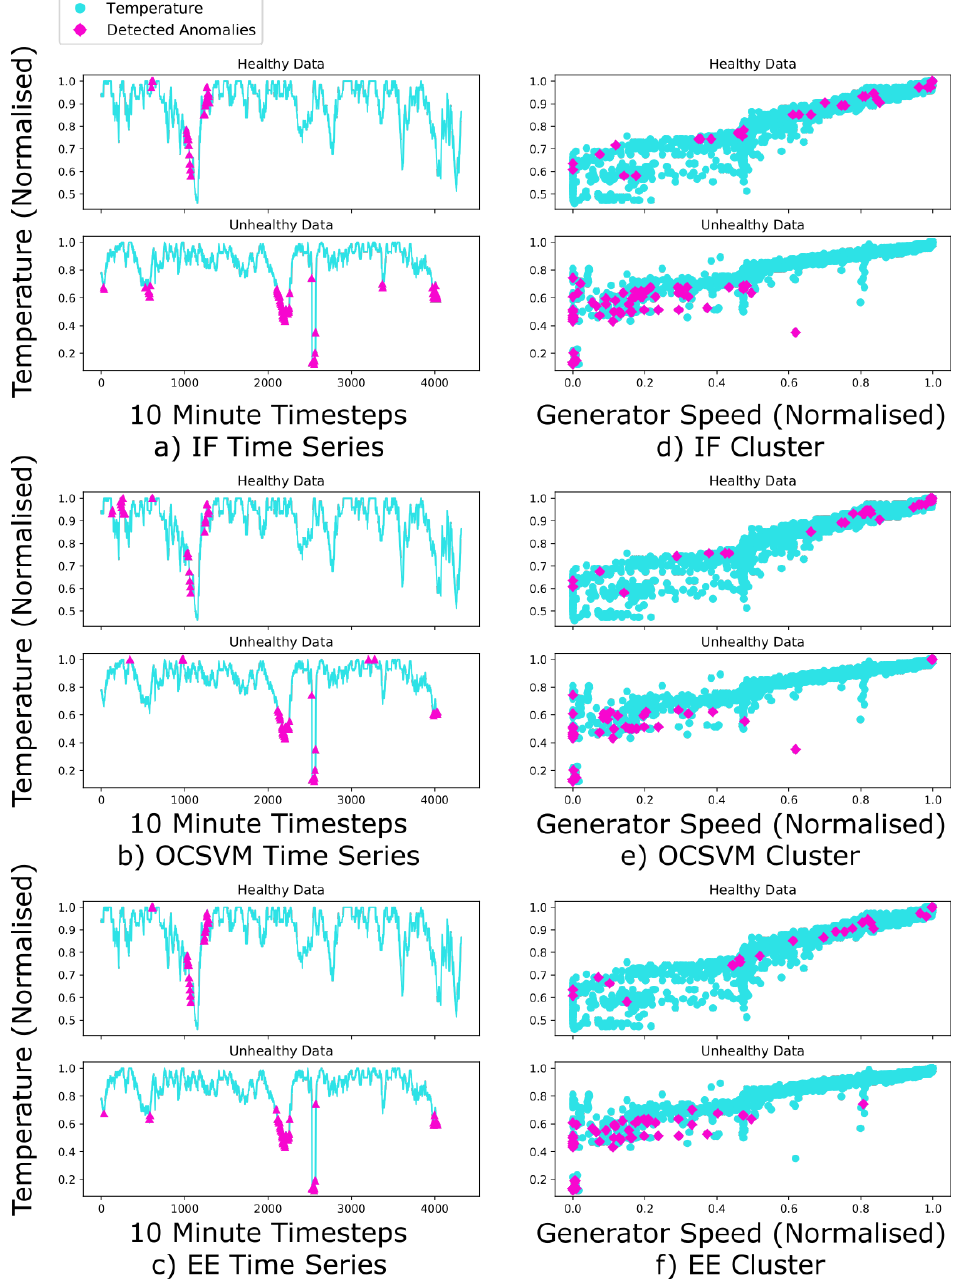
Figure 5. These figures show anomalies for the specific training regime with raw data from the temperature target with three inputs. ( a – c ) The blue (light) line shows the normalised main bearing temperature data. The pink (dark) triangles show when anomalies were detected during the two months. ( d – f ) The blue (light) circles shows the normalised main bearing temperature data. The pink (dark) diamonds show when anomalies were detected during the two